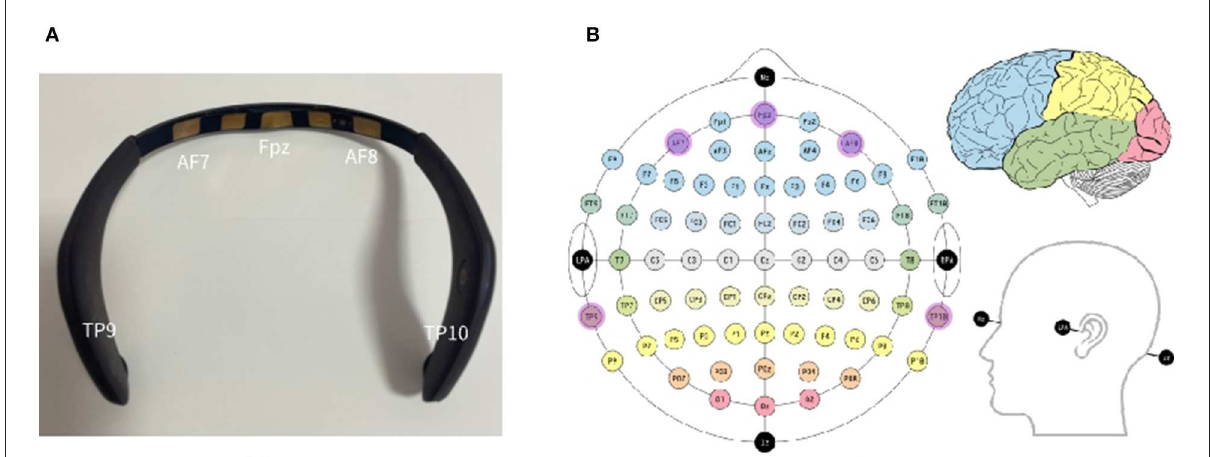
FIGURE1 (A) MUSE 2 EEG headband; (B) EEG electrode positions in the 10-10 system using modified combinatorial nomenclature, along with the fiducials and associated lobes of the brain. Adopted from